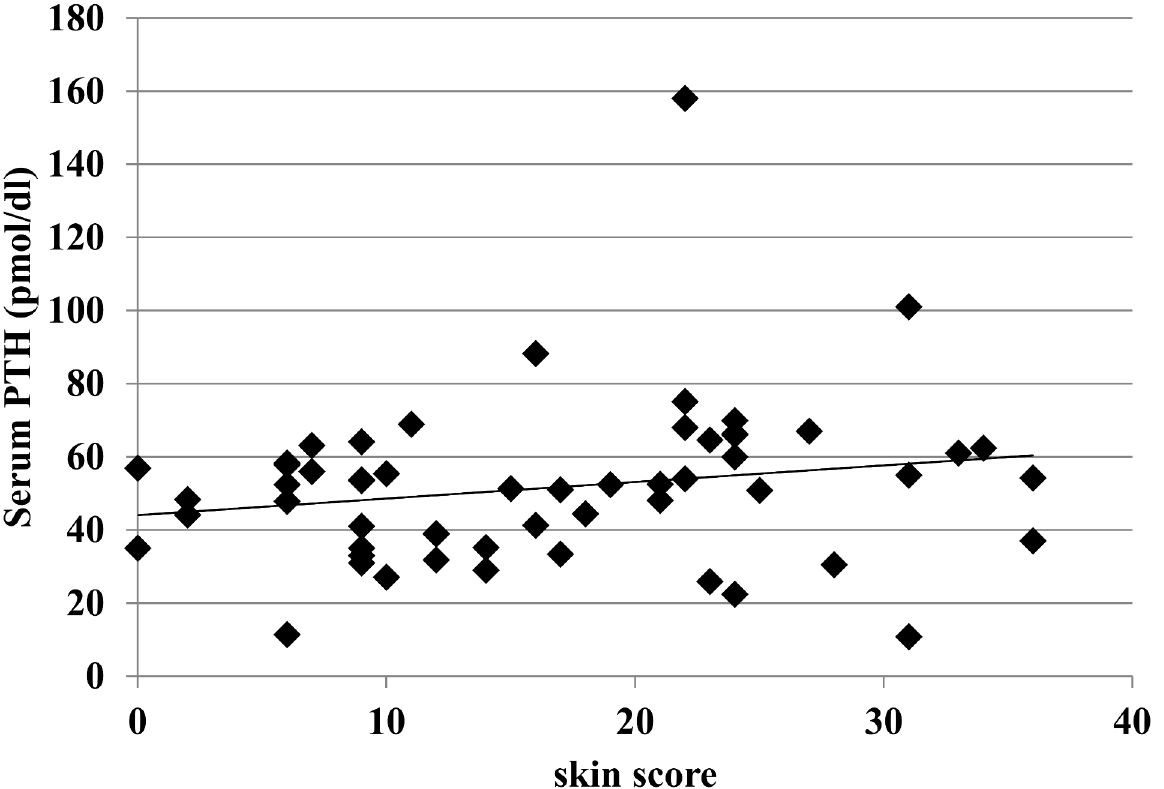
Fig 5. Relationship between the degree of skin fibrosis assessed by modified Rodnan skin score and PTH serum levels in SSc patients. There is no relationship between PTH serum levels and Rodnan skin score, although a tendency to a direct correlation was observed, which did not reach statistical